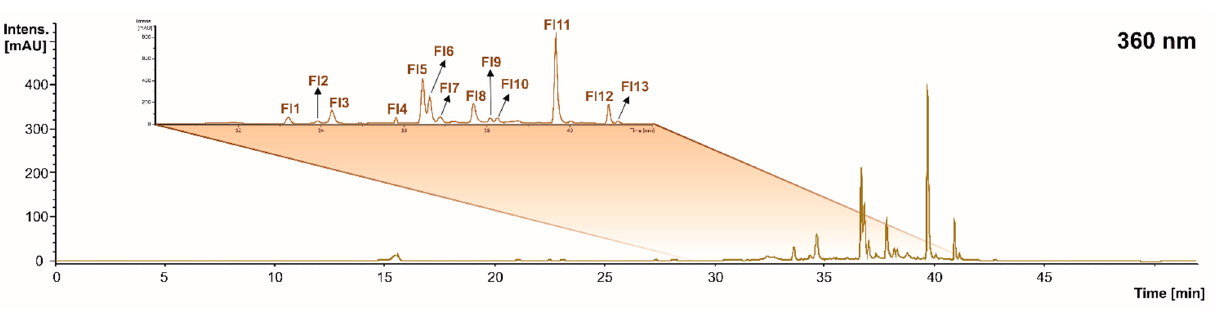
Figure 4. Chromatogram recorded at 360 nm representative of the flavonols (Fl) recorded in grape stems, grape pomace, and wine lees. Identification of the peaks annotated according to Table 4. Table 4. Identification of flavonols in grape ( Vitis vinifera L. var. ’Monastrell’) stem, pomace, and wine lees by HPLC-PDA-ESI-MSn operating in negative mode.